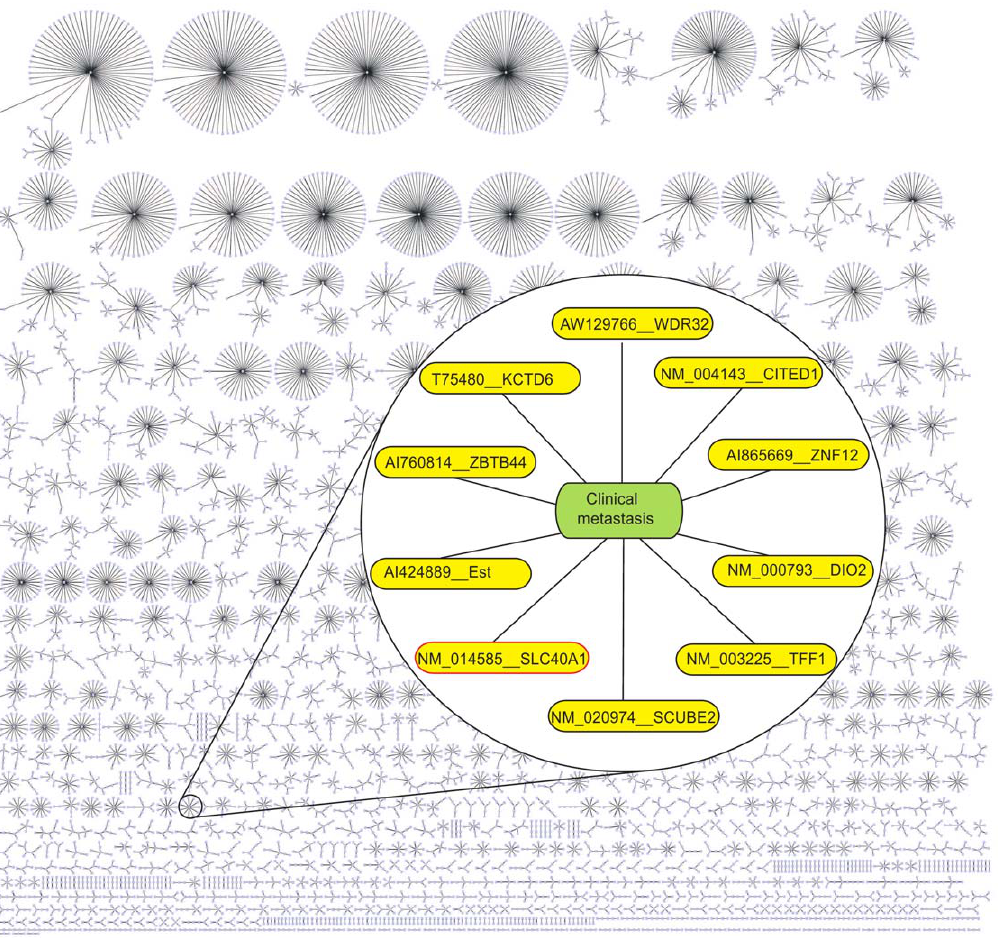
Figure 2. A k NN (for k =1) graph from the breast cancer dataset with 24,158 probe sets in [ 28 ] . Zooming into the cluster containing only the clinical metastasis , brings out a list gene that are less highlighted in [28] but interesting enough to warrant further investigation. For instance, Ferroportin (solute carrier family 40 (iron-regulated transporter), member 1- SLC40A1) is one of less correlated gene in the original publication (see the Supplementary Table 3 (http://bioinformatics.nki.nl/data/nejm_table3.zip) of van de Vijver et al. [28]), but recent studies suggest that low level of Ferroportin increases breast cancer recurrence risk [39–42]. We utilized the freely available yEd software (http://www.yworks.com/) to visualize this graph.